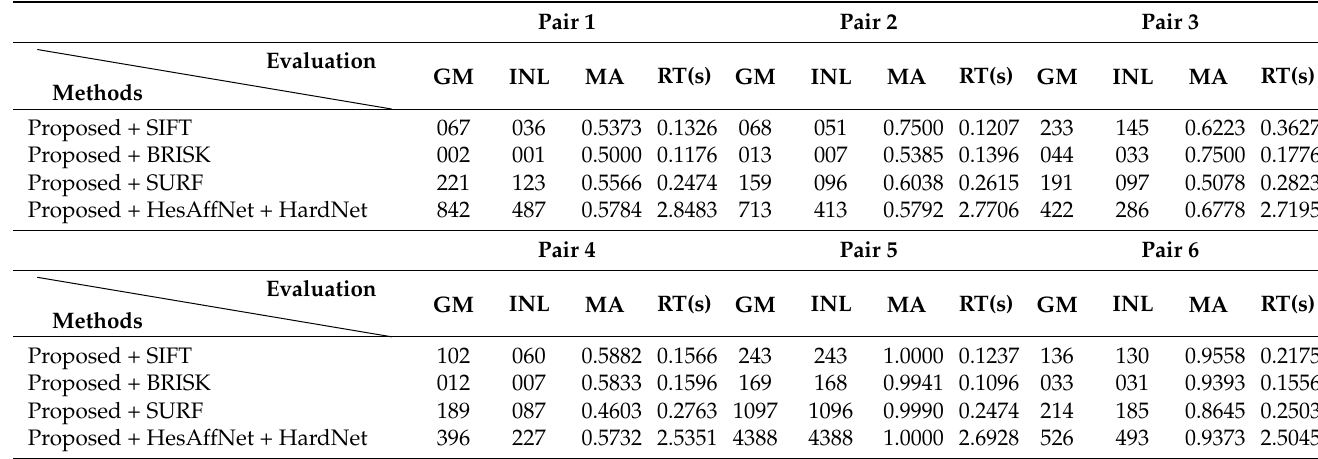
Figure 9. This is a schematic diagram of the matching results of the images after attribute transfer: ( a ) matching results using SIFT, ( b ) matching results using BRISK, ( c ) matching results using SURF, and ( d ) matching results using HesAffNet + HardNet. Table 1. Evaluation results of image pair 1 to image pair